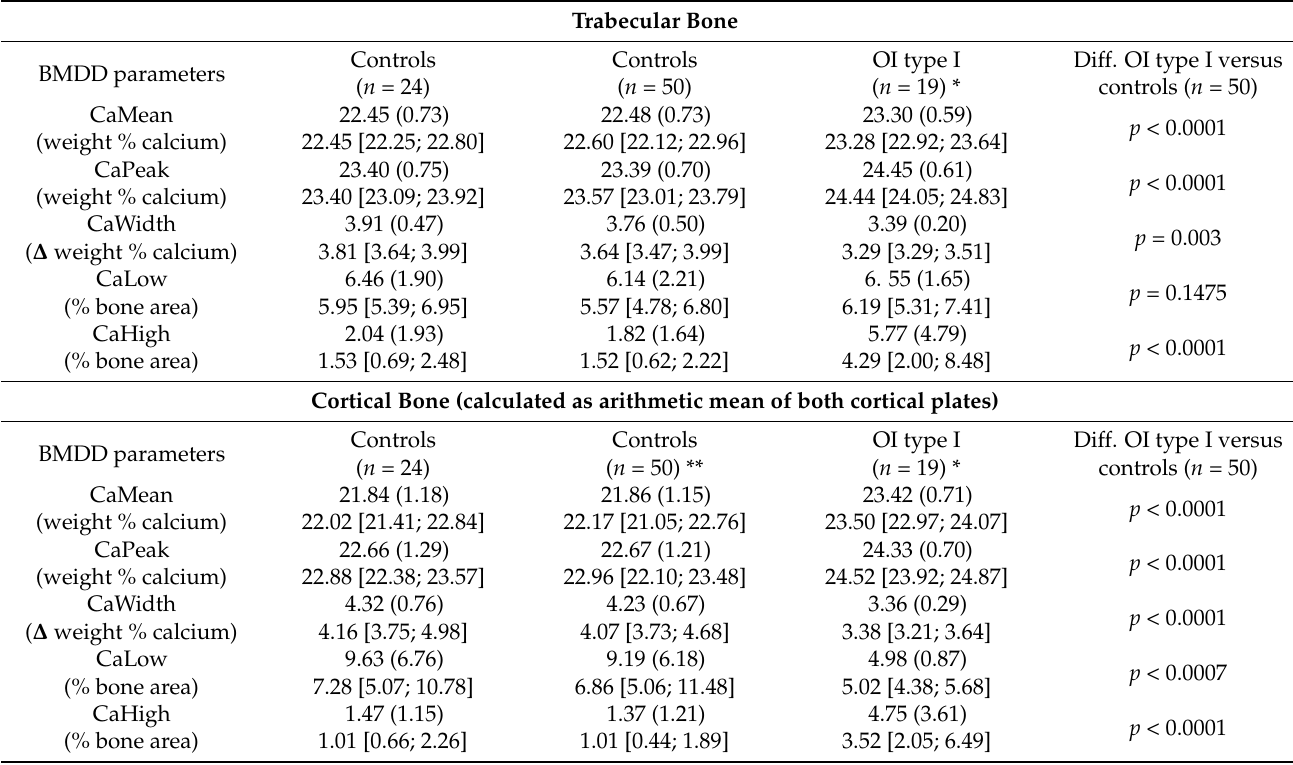
Table 2. BMDD in controls and OI type